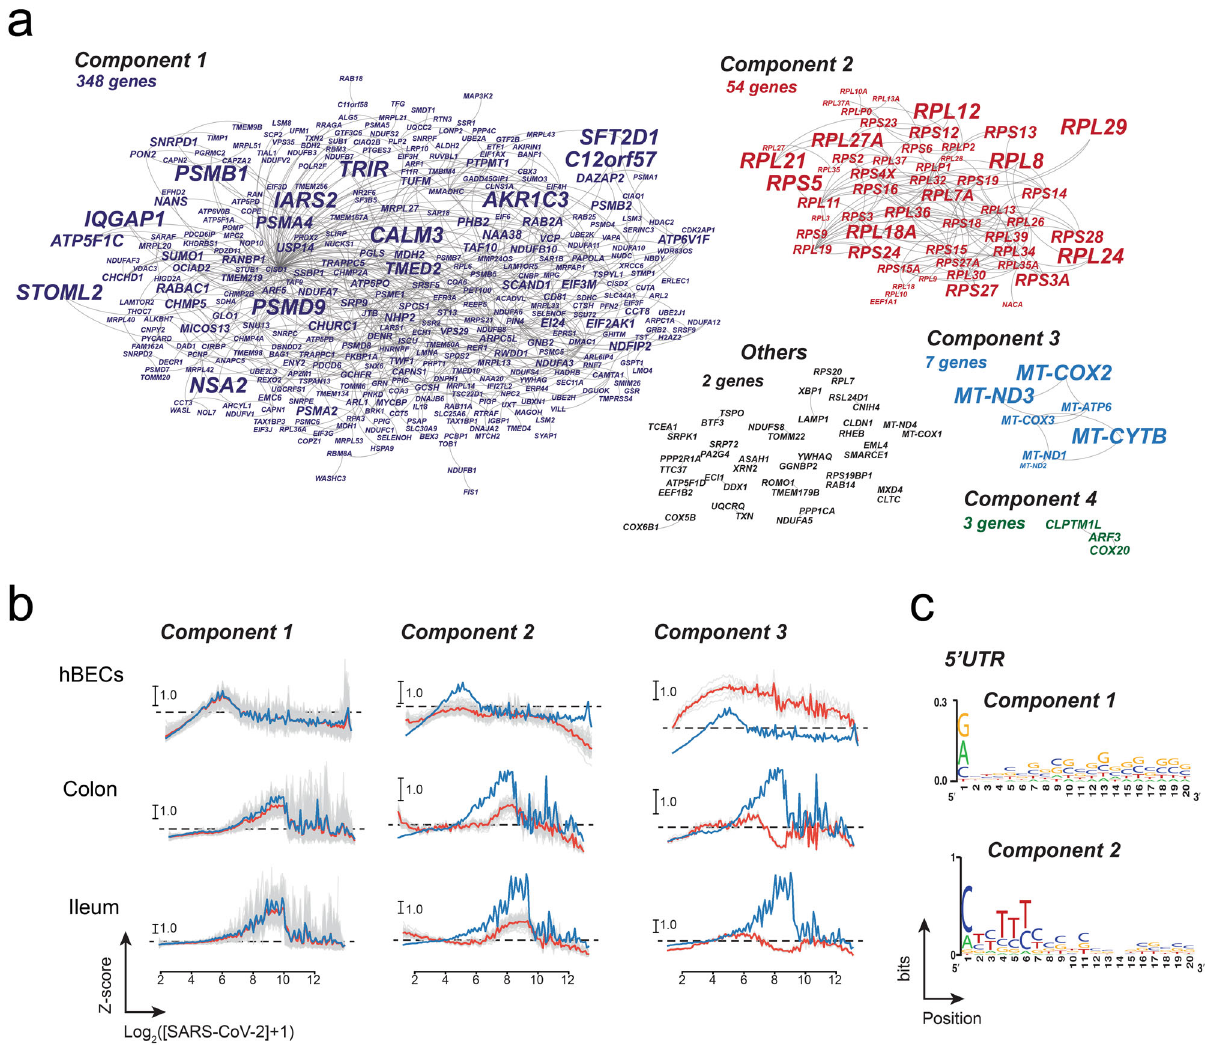
Fig. 6 Correlated responses to SARS-CoV-2 infection common to the three cell types. a The network was constructed by connected pairs of genes exhibiting a signi fi cant correlation in their transcriptional pro fi les in the three datasets. This analysis resulted in a network with 25 connected components comprising between 348 to 2 genes. Node size is scaled to represent the clustering coef fi cient. b The transcriptional pro fi les of the three largest connected components revealed distinct response pro fi les associated with the mean response (component 1), genes involved in translation (component 2), and mitochondria-encoded genes (component 3). In each example, pro fi les of individual genes are colored gray; the average transcriptional response of genes within each module is shown in red. For comparison, the mean response pro fi le is shown in blue. c Sequence logos of the 5 ′ UTRs reveal the presence of characteristic sequence signatures for genes belonging to modules 1 and